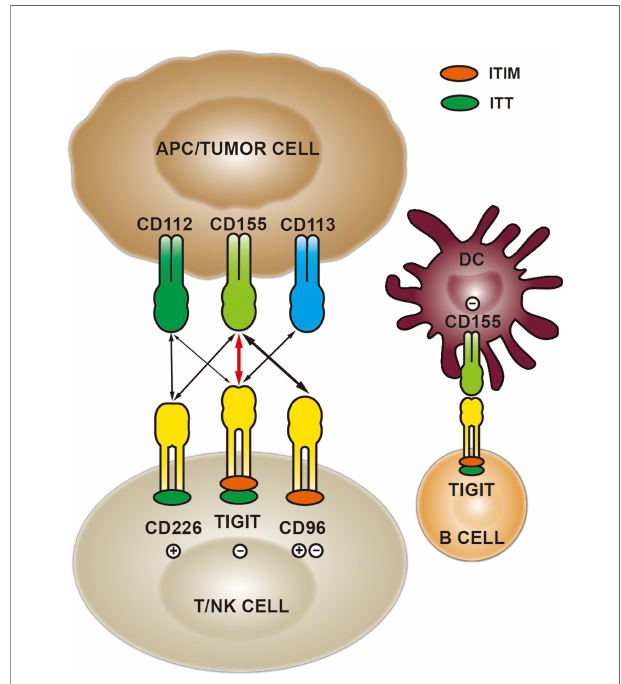
FIGURE 1 | The expression and interaction of TIGIT/CD155 in the tumor